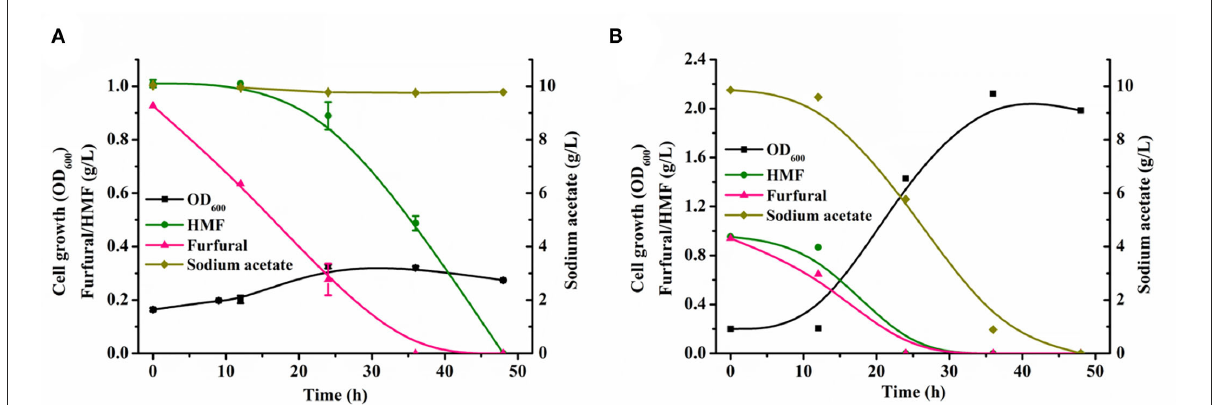
FIGURE2 Comparing growth and conversion of inhibitors between original strains and evolved strains in mock lignocellulosic hydrolysate. Growth and inhibitors conversion profiles of the original strains (A) , the growth and inhibitors conversion profiles of the evolved strains (B) in the minimal medium supplemented with 1 g/L of HMF, 1 g/L of furfural, and 10 g/L of sodium acetate during 48h cultivation. All data are the mean value ± standard deviation of independent two experiments.